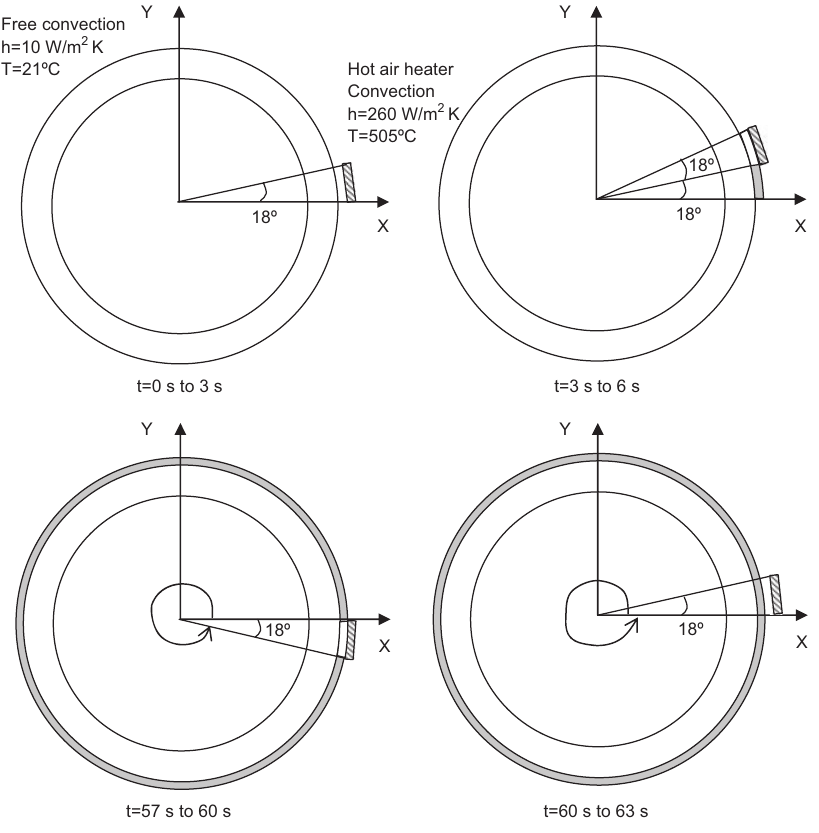
Figure 6 Schematic procedure of AFP modeling.